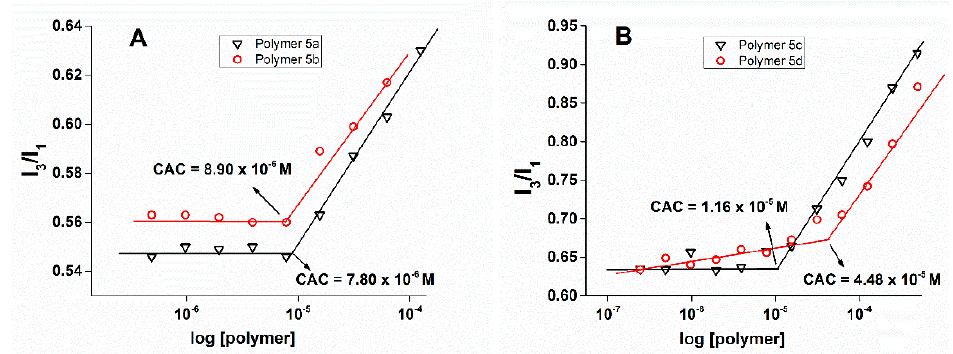
Figure 1. Evaluation of CAC of polymers using pyrene as a hydrophobic probe and by measuring I 3 /I 1 ratio: ( A ) polymers 5a and 5b ; ( B ) polymers 5c and 5d .